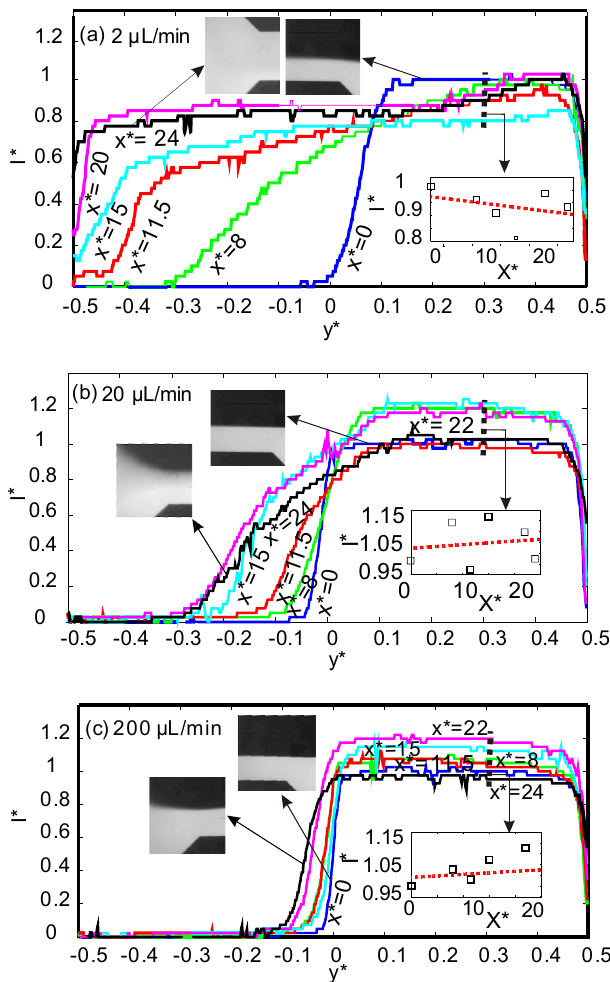
Figure 2. Normalized intensity across the normalised channel width y * for six positions of x * along the mixing channel with a ferrofluid concentration of 2% vol. ( x * = 0: blue, x * = 8: green, x * = 11.5: red, x * = 15: cyan, x * = 22: purple, x * = 24: black) and three flow different flow rates: ( a ) 2 µL/min; ( b ) 20 µL/min; ( c ) 200 µL/min.